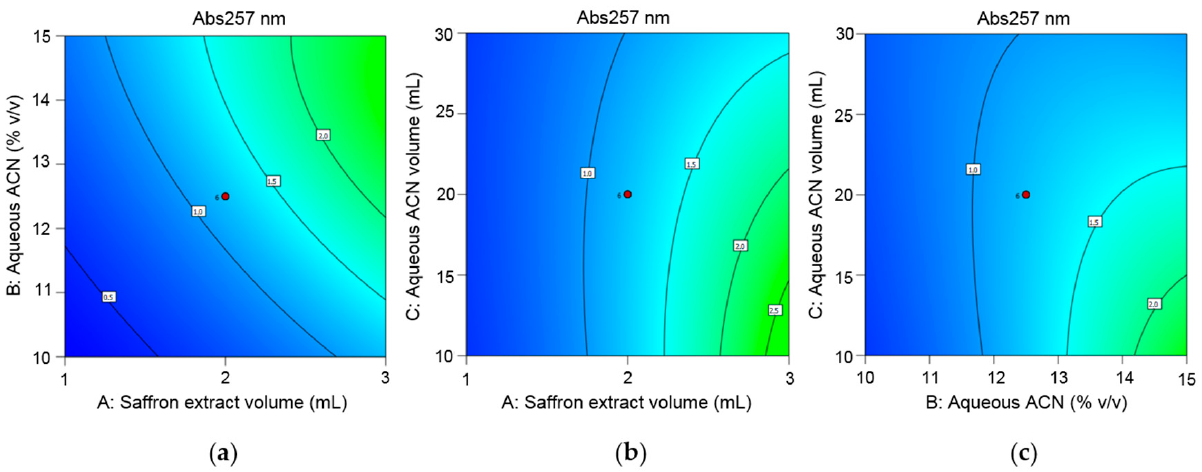
Figure 2. Contour plots of ( a ) volume of saffron extract (mL) and % v / v aqueous ACN, ( b ) volume of saffron extract (mL) and aqueous ACN volume (mL), ( c ) % v / v aqueous ACN and aqueous ACN volume (mL), for picrocrocin model.